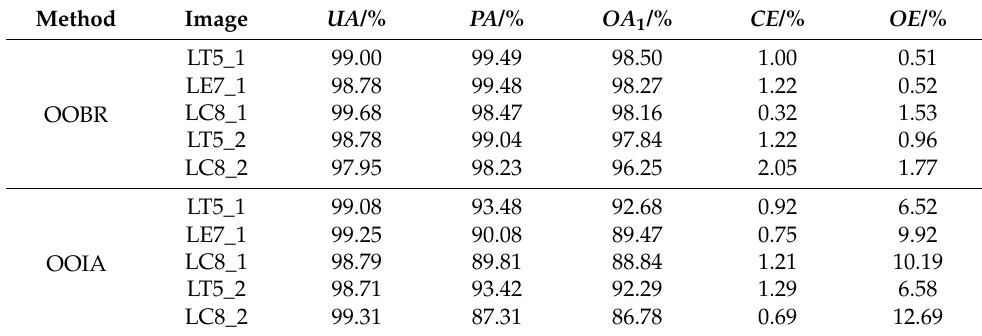
Table 4. Accuracy of the results with OOIA and OOBR.